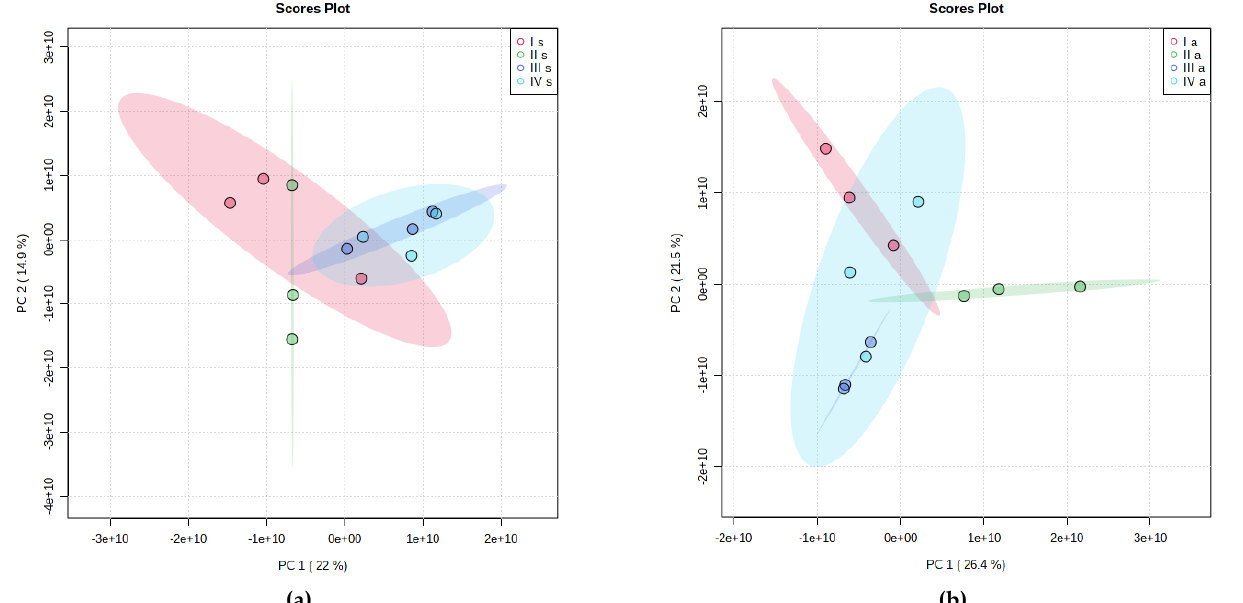
Figure 6. PCA analysis of metabolite network of biolayers from Ruskeala quarry: ( a ) active vegetation stage; ( b ) late vegetative stage.